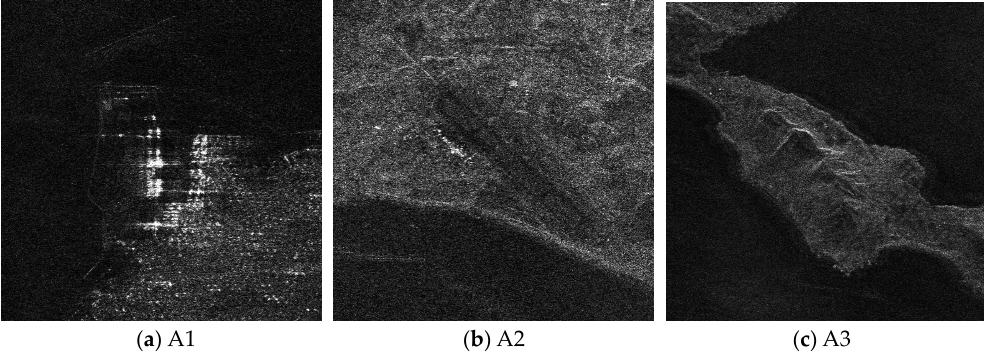
Figure 23. The enlarged view of three areas in the algorithm result presented in this paper when data is periodically missing along the azimuth direction. ( a ) Area A1. (b ) Area A2. ( c ) Area A3.